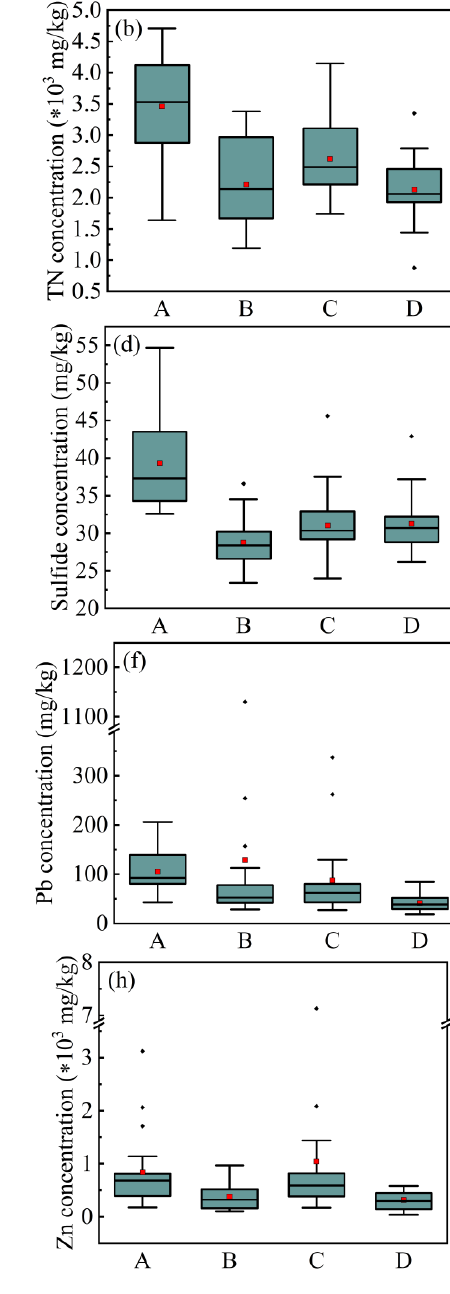
Figure 9. Box-plot of ( a ) TK, ( b ) TN, ( c ) PO, ( d ) sulfides, ( e ) AOX, ( f ) Pb, ( g ) cyanides, and ( h ) Zn level in different catchments. *: multiplication sign.